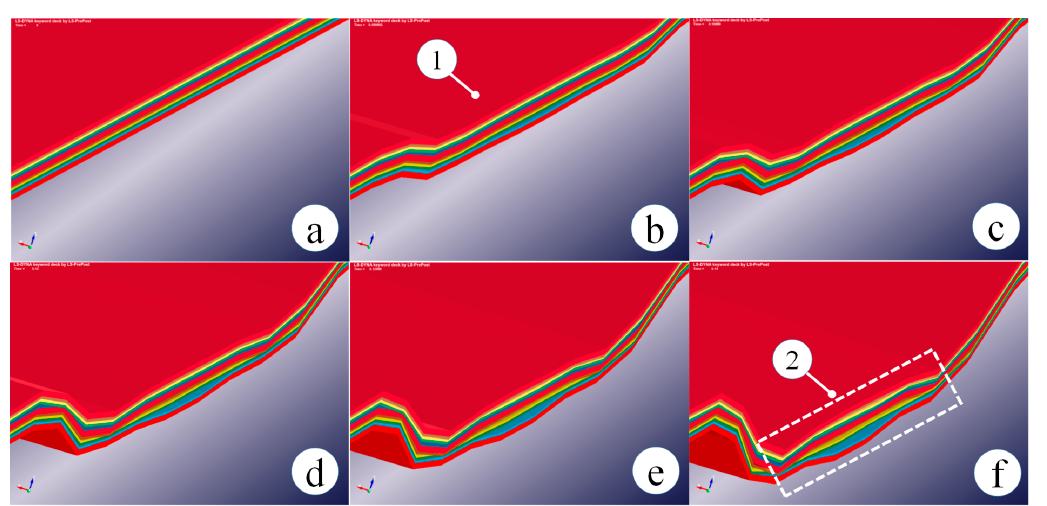
Figure 5. Sub-laminates through the GLARE thickness attributed to debonding and delamination at ( a ) 0 ms (initial state), ( b ) 0.099 ms, ( c ) 0.11 ms, ( d ) 0.12 ms, ( e ) 0.13 ms, ( f ) 0.14 ms; 1 indicates the impacted side; 2 stands for the impact zone where all the interfaces failed; material and interface properties correspond to room temperature; impact velocity 82 m / s; the fragmented projectile is not included in the imagery to facilitate the pictorial